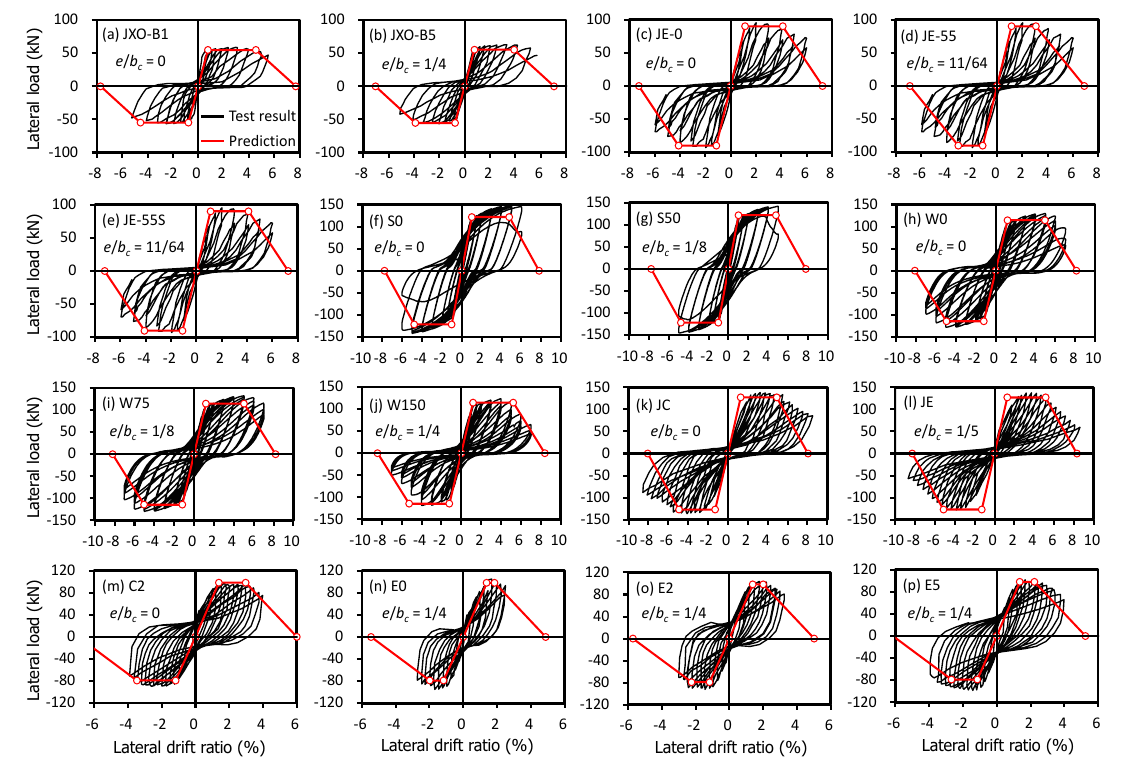
Figure 8. Comparison between test results and predictions with NZS 3101-2006.